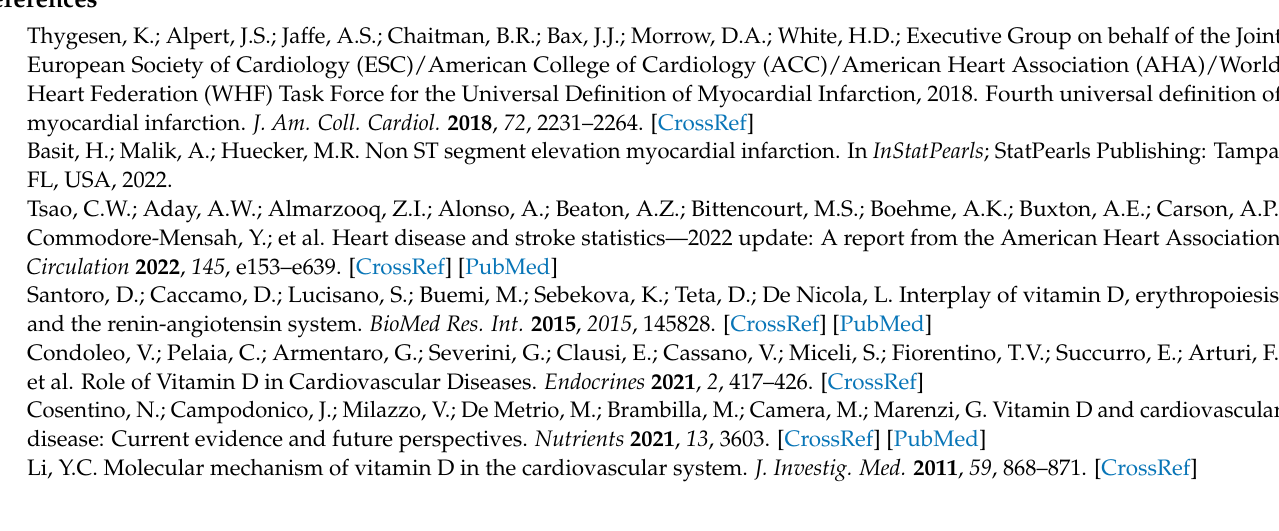
Table S2: Comparison of Cardiac biomarkers and non-coding RNA levels between different VDR genotypes among both groups; 1 and 2, and Table S3. The ability of the assessed cardiac biomarkers and ncRNAs for predication of heart failure and MACE among complicated ACS